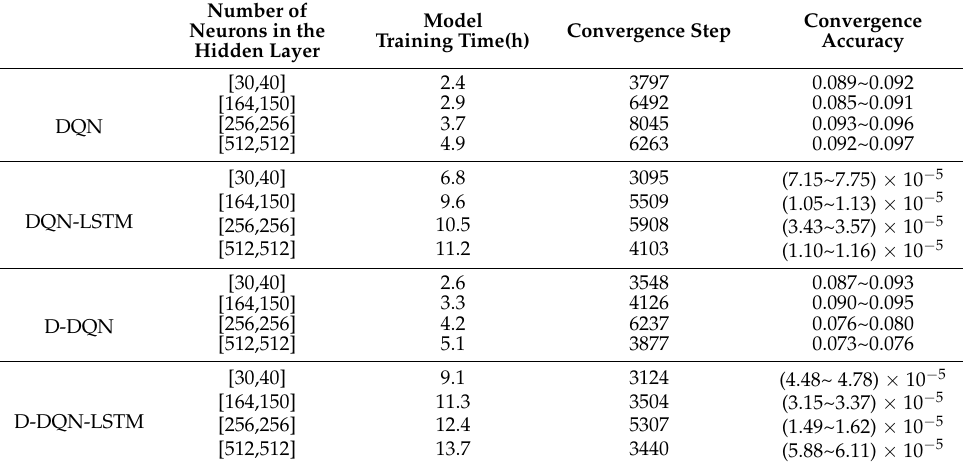
Table 2. Comparison of the results of different algorithm